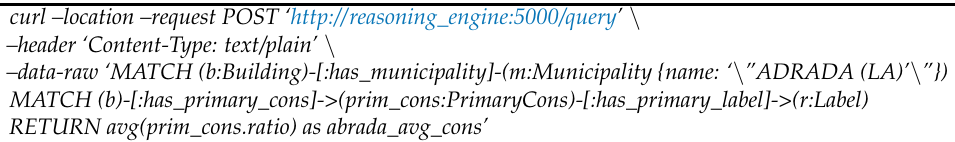
Table 5. Retrieve average primary consumption for buildings located in ABRADA municipality.